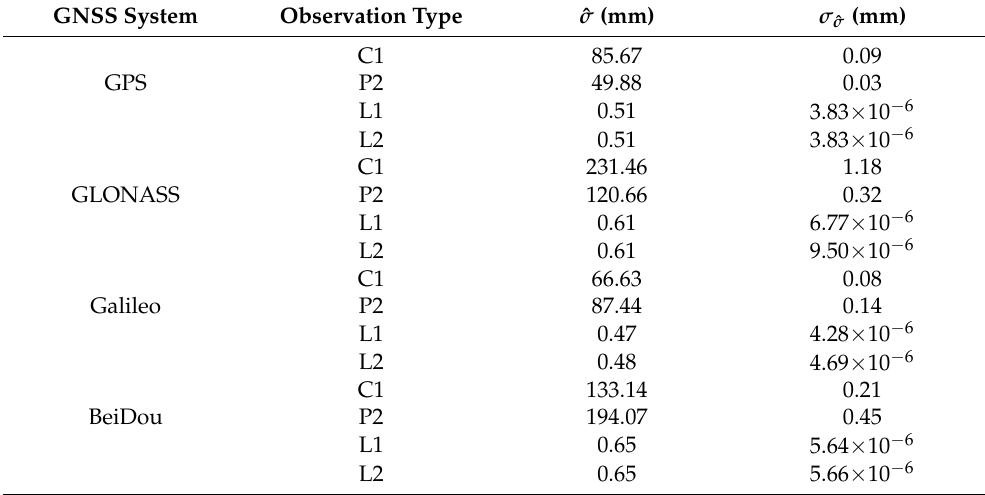
Table 3. Standard deviation of the phase and code observations and their precision for each system for SEPT POLARX5 receiver over a very short